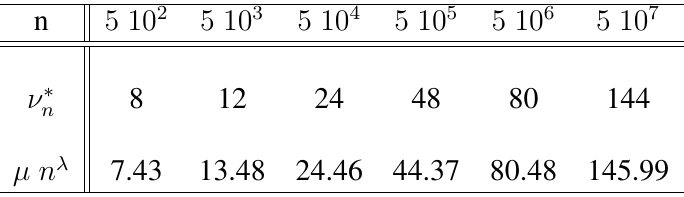
and those produced by ν ∗ n